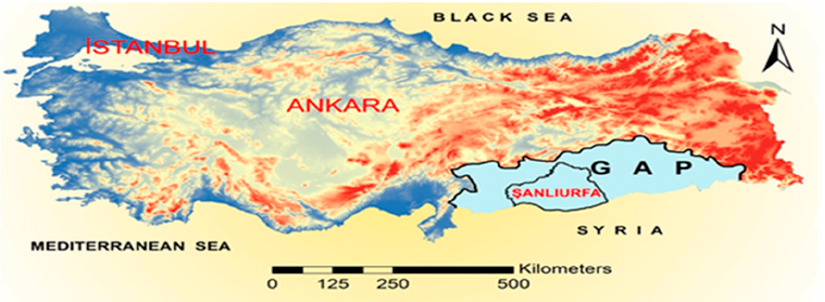
Figure 1. Turkey, GAP, and Ş anl ı urfa.